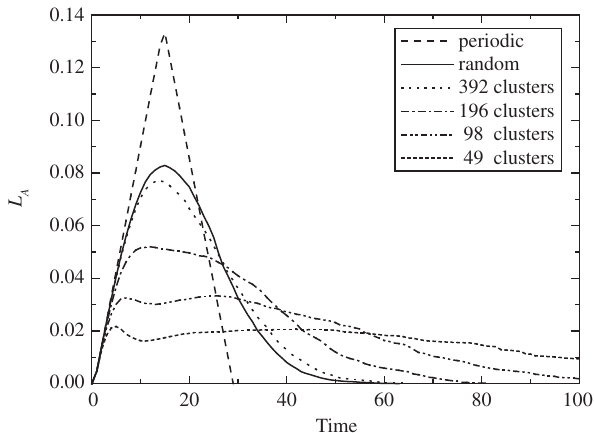
, A is more pronounced for a A